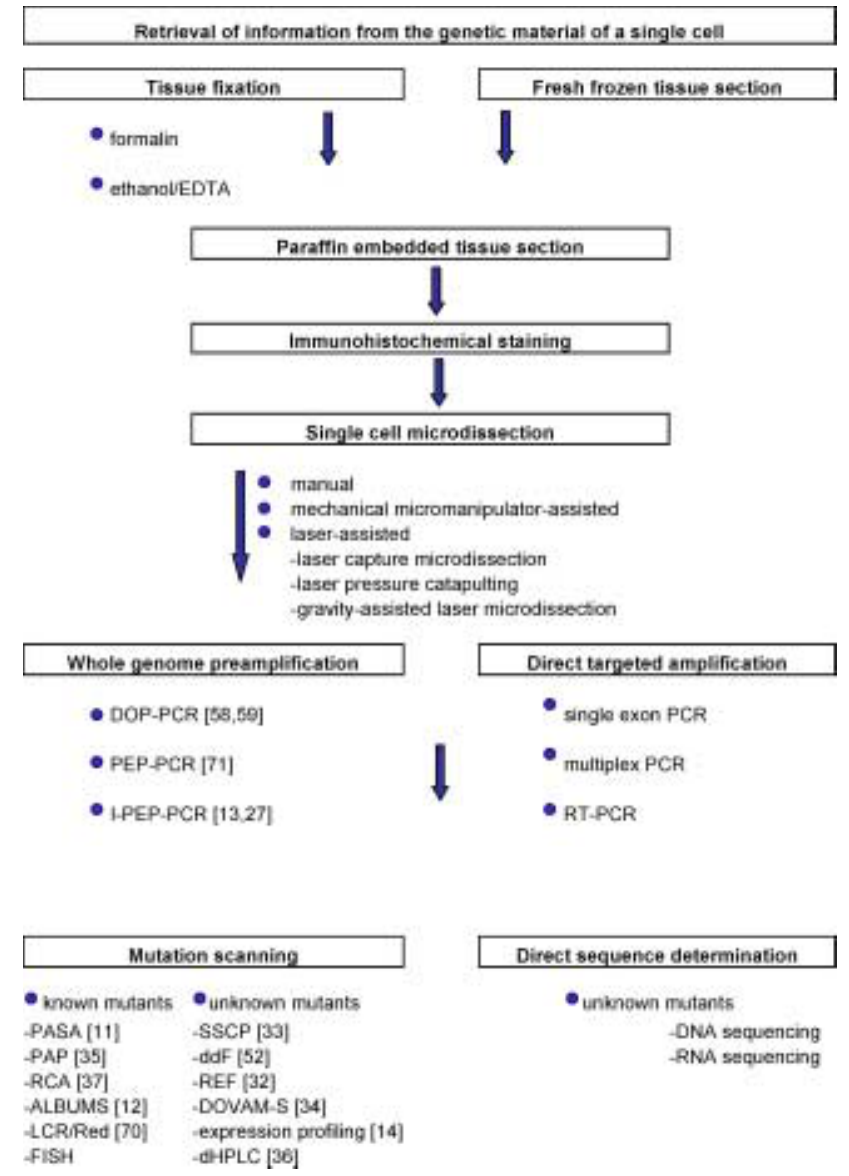
Fig. 1. Schematic demonstration of different possibilities to acquire genetic information using tissue microdissection. Nowadays, researchers can chose from a variety of methods depending on the desired information. This figure can be viewed on http://www.esacp.org/acp/2002/24-4_5/